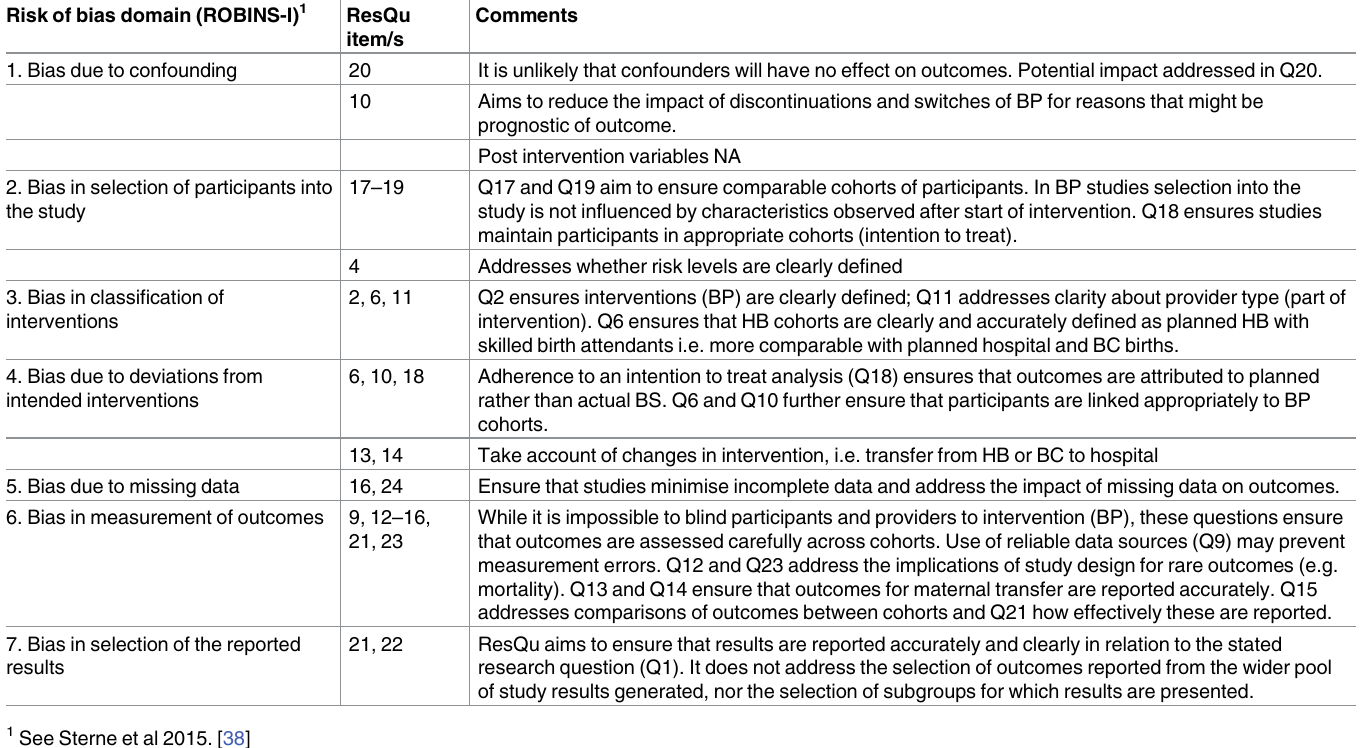
Table 5. Comparison of ResQu Items with domains in Cochrane risk of bias too